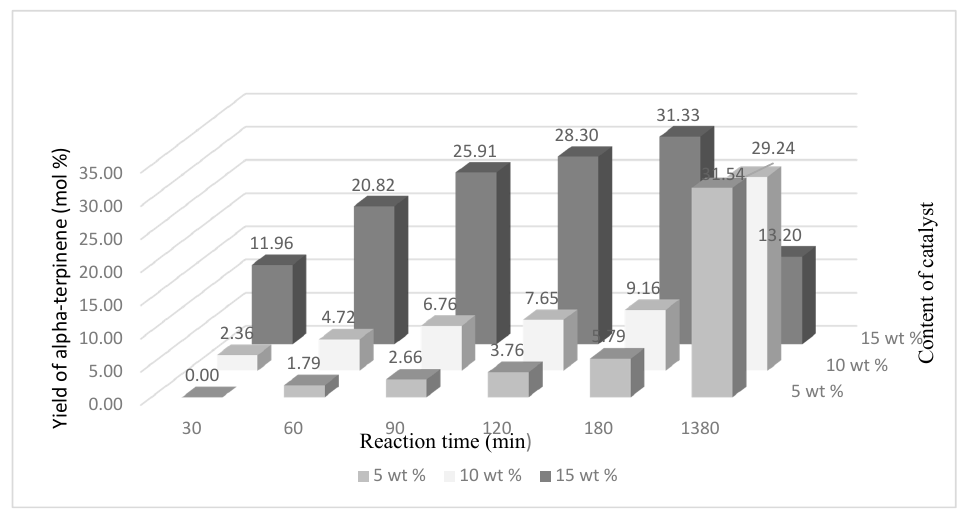
Figure 6. Influence of the amount of the catalyst and the reaction time on the yield of α -terpinene, for the reaction carried out at 160 °C. The amount of the catalyst was 5, 10, or 15 wt %, and the reaction time was 30, 60, 90, 120, 180, or 1380 min.